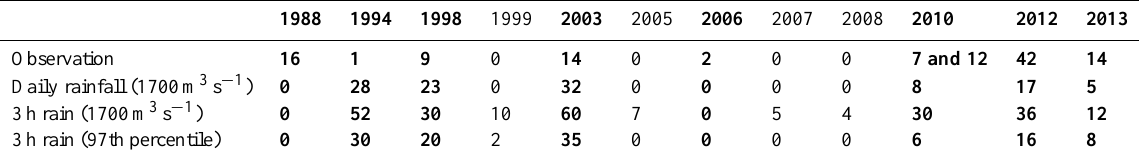
Table 1. Observed and simulated flooding periods in day in Niamey between 1983 and 2013. Years in bold font correspond to observed floods. For simulations years in bold font and equal to 0 correspond to non-detection and years in normal font correspond to